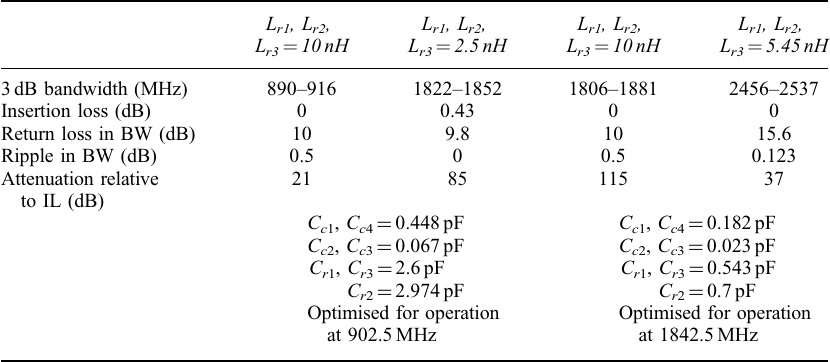
TABLE III Conventional Filter Component Values for 2 Frequency